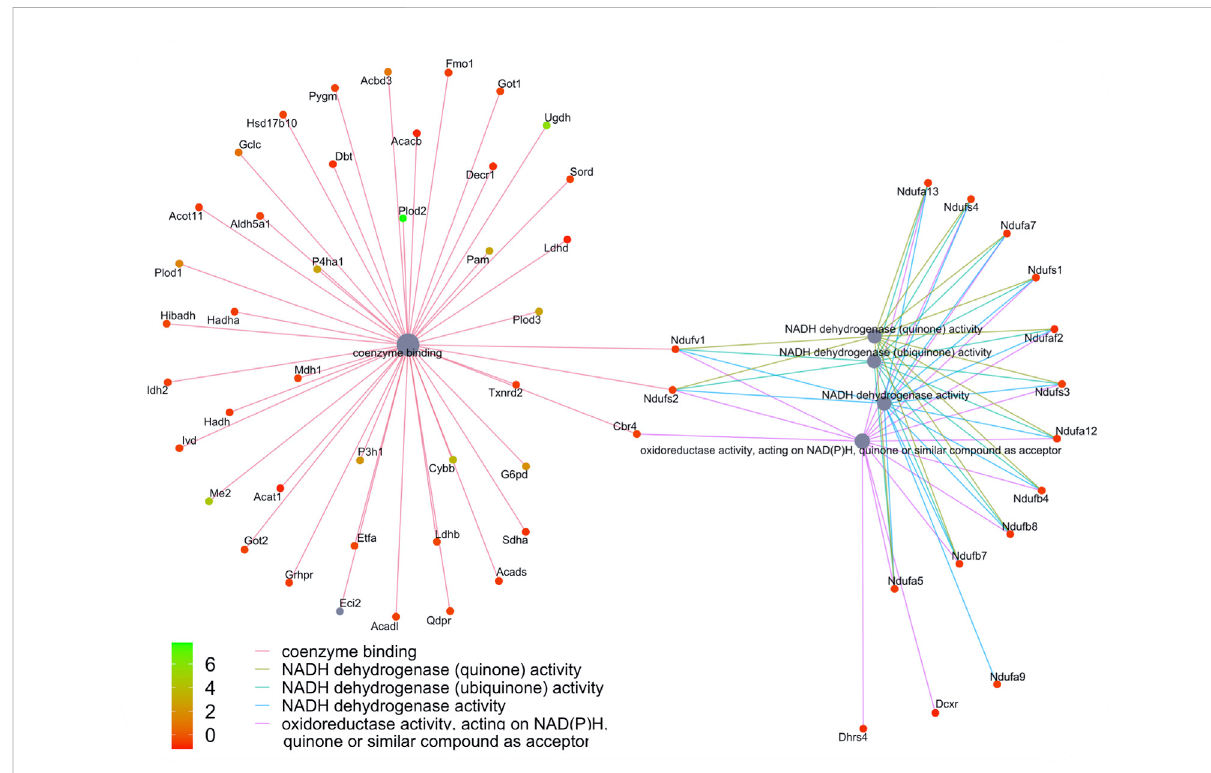
FIGURE 7 Network of GO enrichedterms within the Biological Process Domain. An enrichment of termsdescribing “ NADP dehydrogenase ” wasresolved when we performed functional analysis on the 410 proteins that are also differentially regulated at the transcript